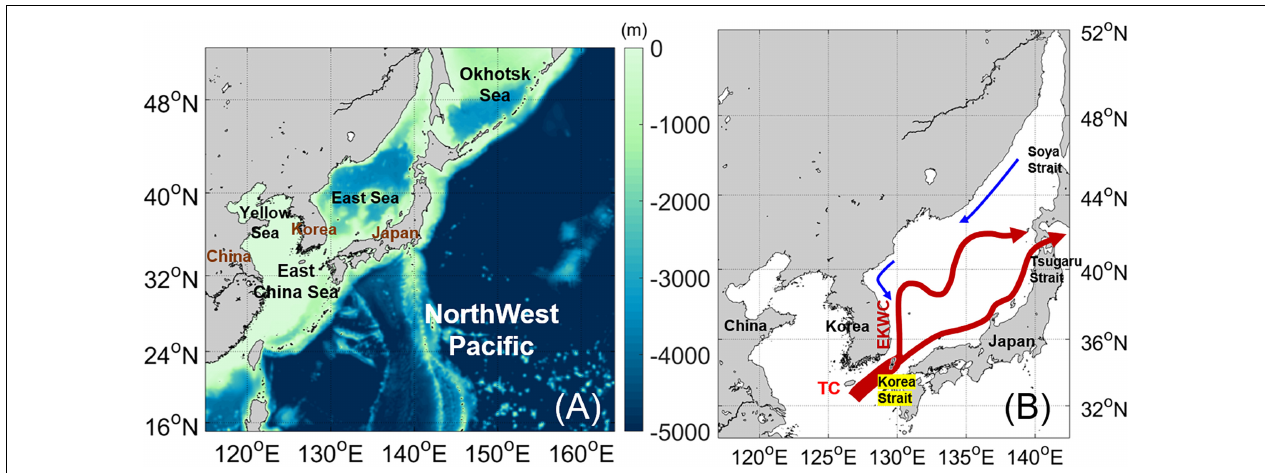
FIGURE 1 | (A) Bottom topography (unit: m) of the NWP in the RCM. (B) Main currents present in the study area: Tsushima Current (TC) and the East Korean Warm Current (EKWC).